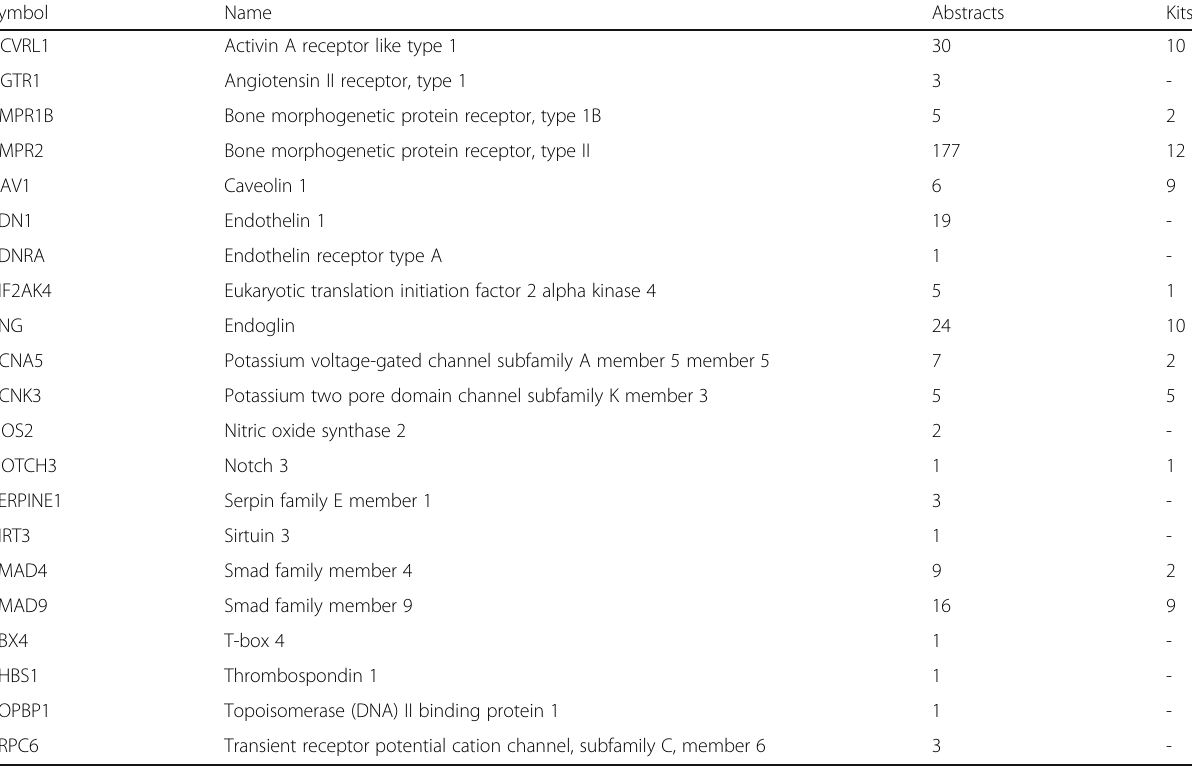
Table 2 The 21 genes having genetic evidence of mutations